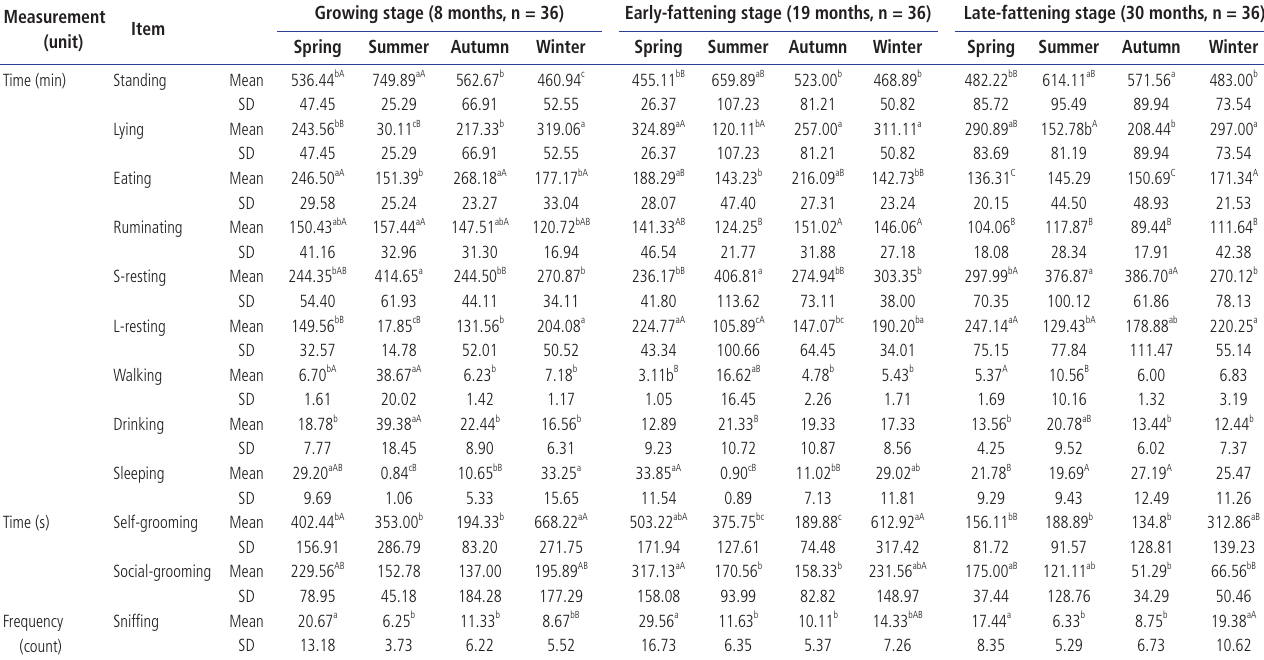
Table 4. Behavioral changes in Hanwoo steers (n = 108) during daylight (13 h/06:00 to 19:00 h) Growing stage (8 months, n = 36) Measurement Item (unit) Time (min) Standing